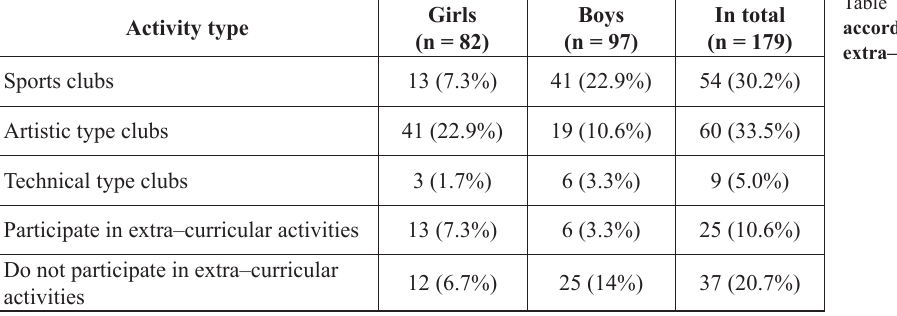
Table 1. Distribution of pupils according to their participation in